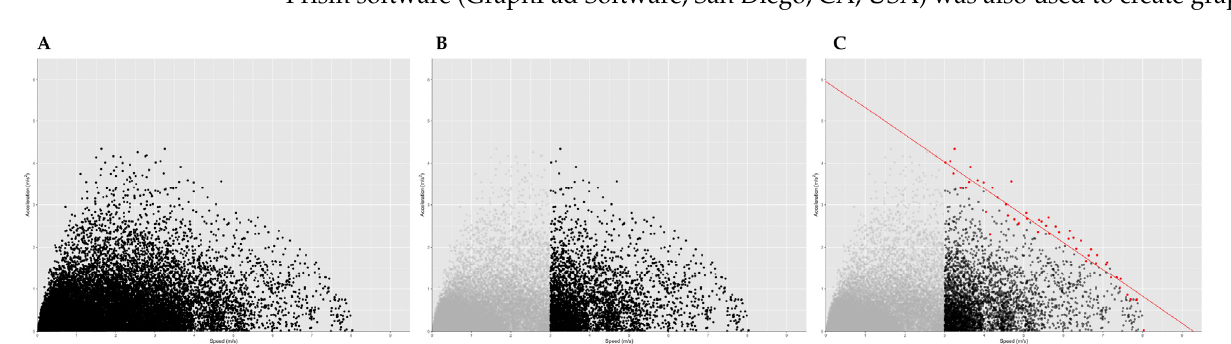
Figure 2. Acceleration–Speed (AS) profile analysis criteria proposed by Morin et. (2021) for a player in a match. ( A ) All acceleration–speed points are plotted. ( B ) Only accelerations between 3 m/s and the individual maximal speed were selected (black points). This selected range was divided into subintervals of 0.2 m/s velocity (e.g., 3, 3.2, 3.4 m/s, etc.). ( C ) The two maximum acceleration values were taken for each interval (red points). The statistical technique of simple linear regression (red line) was used to fit the two maximum acceleration–speed points per subinterval (approximately 50 − 55 ± 4 points depending on the maximum individual velocity). Outliers AS points were removed to increase the linear regression fitting and accuracy of the results. Finally, the A 0 (X = 0 and y-intercept) and S 0 (Y = 0 and x-intercept) values were obtained from linear regression (Y = a*X + b) for each player per match.